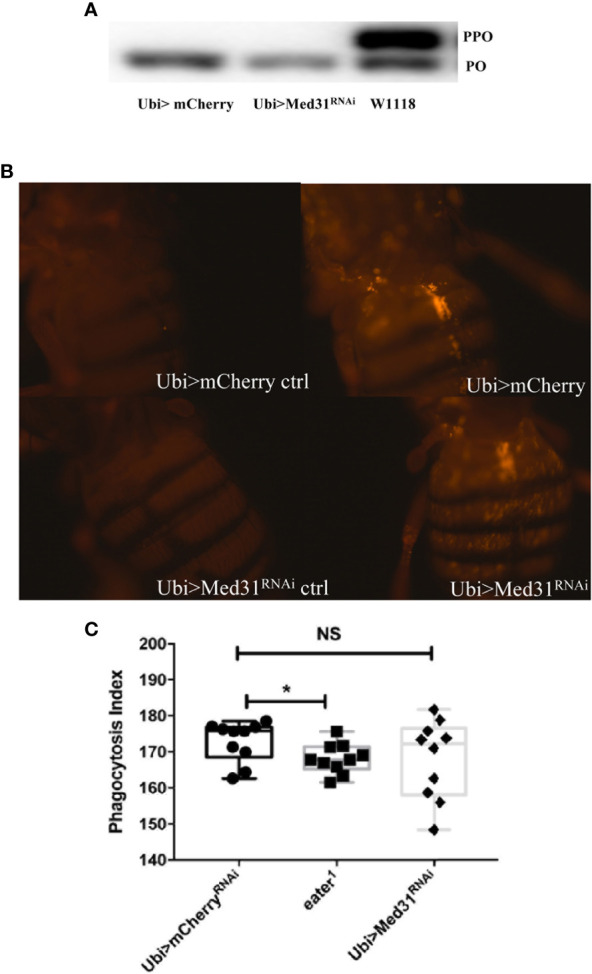
Melanization and phagocytosis are not affected in Med31 RNAi flies. (A) prophenol oxidase (PPO) cleavage four hours after a M. luteus challenge was detected by Western blot analysis. The cleavage of PPO into phenol oxidase (PO) is shown in the picture. PPO cleavage into PO was total for both Med31 RNAi and mCherry RNAi control flies, while that induced in another wild-type control, w1118, was only partial. This blot is representative of three out of four independent experiments. The phagocytic activity of flies was detected using injected pH-RODO-labelled E. coli, which become fluorescent when internalized into mature phagosomes. (B) Flies were injected with latex beads as a phagocytosis-deficient control (left panels). The phagocytic activity of Med31 RNAi flies was not altered compared to the mCherry RNAi control flies (right panels). (C) Quantification of the fluorescence emitted by internalized bacteria. The eater1 phagocytosis-deficient mutant flies represent a positive control. There was no significant difference between Med31 RNAi flies and the mCherry RNAi control flies. Each dot represents the fluorescence measured in a single fly. Three independent experiments were performed. *P < 0.05. Median ± SEM are indicated. NS: not significant.